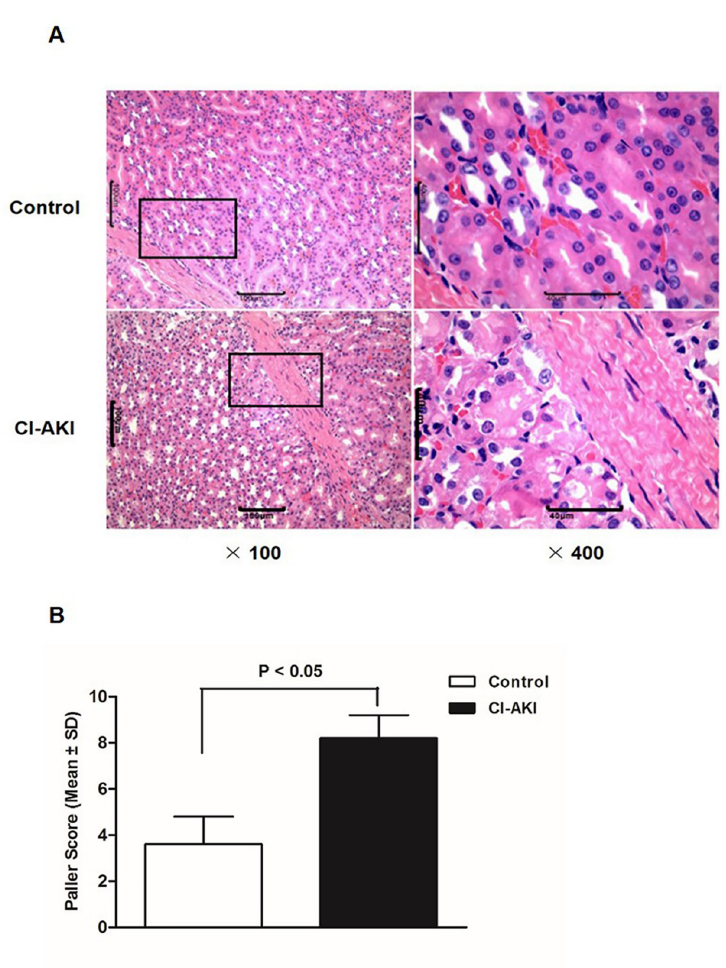
Fig 1. Histopathological assessment of the kidneys of the control rats and CI-AKI rats by H&E staining. (A) CM treatment induces representative histopathological changes in the outer medulla of H&E-stained kidney sections. (B) Tubular injury is graded by the Paller score, a semi-quantitative evaluation. For each kidney section, 100 tubules from 10 highmagnification ( × 200) fields of the inner and outer medulla are scored. The average Paller score is much higher in CI-AKI rats than controls ((8.2 ± 0.9) vs. (3.6 ± 1.2), P <